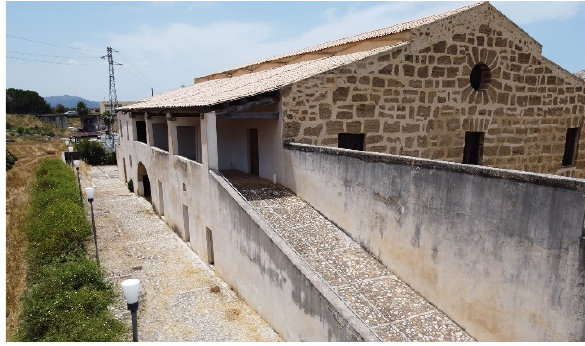
Figure 7 . The southeast side of the “ Real Cantina Borbonica ”.